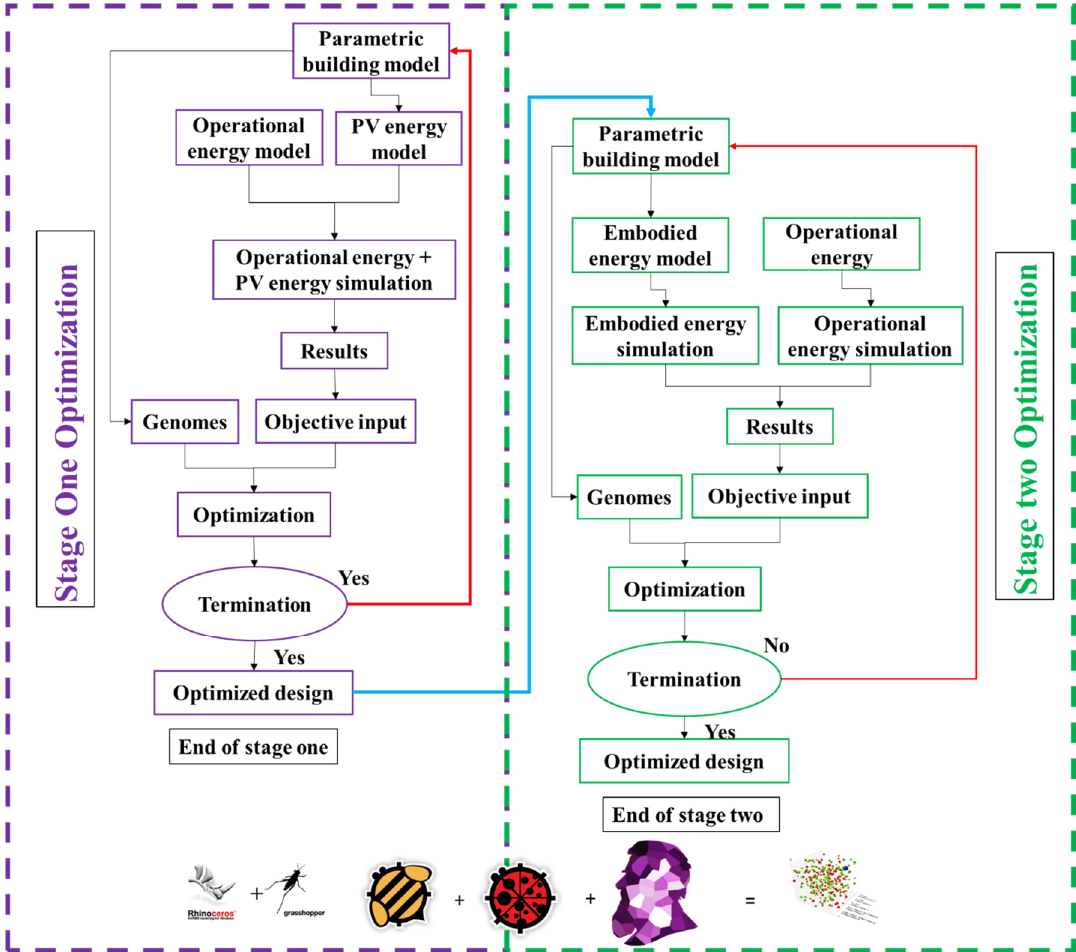
Figure 1. Methodological framework of the study.